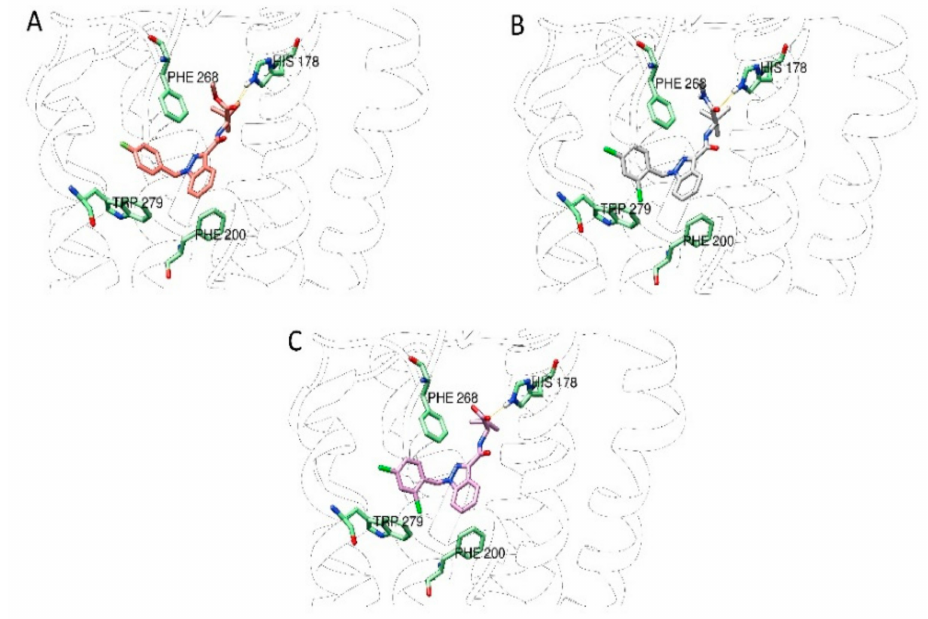
Figure 8. Best ranked pose of MDMB-Fubinaca ( A ), LONI11 ( B ) and LONI4 ( C ) docked to the CB1